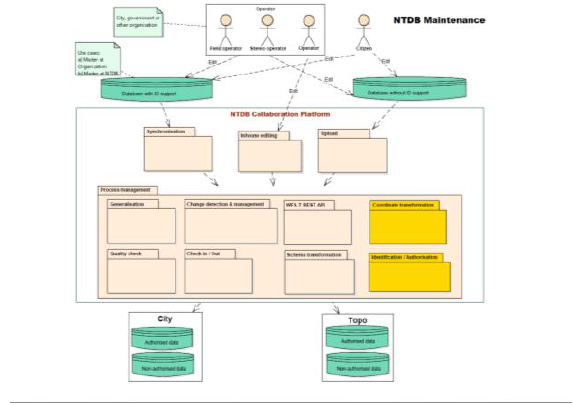
Figure 2. Technical Architecture of the NTDB The preference is towards open source modules if